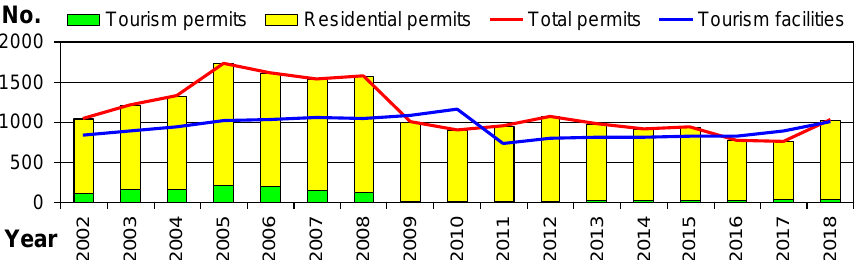
Figure 8. Dynamic of the number of tourism-related (green bars) and residential (yellow bars) building permits issued in the administrative units of the Romanian seaside during 2002–2018, in conjunction with the dynamic of the total number of permits (red line) and tourism facilities built up (blue line). Source of data: Romanian Statistical Yearbooks (National Institute for Statistics).